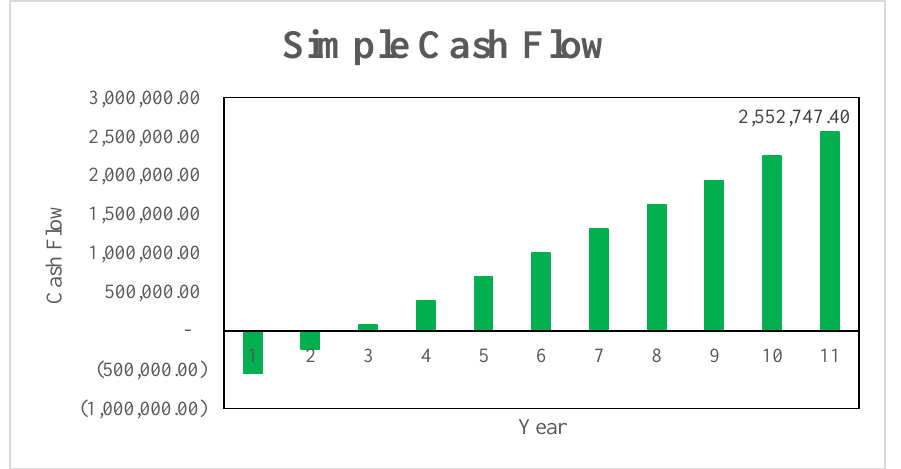
Figure 2. Simple cash flow for the investment of 11 years.